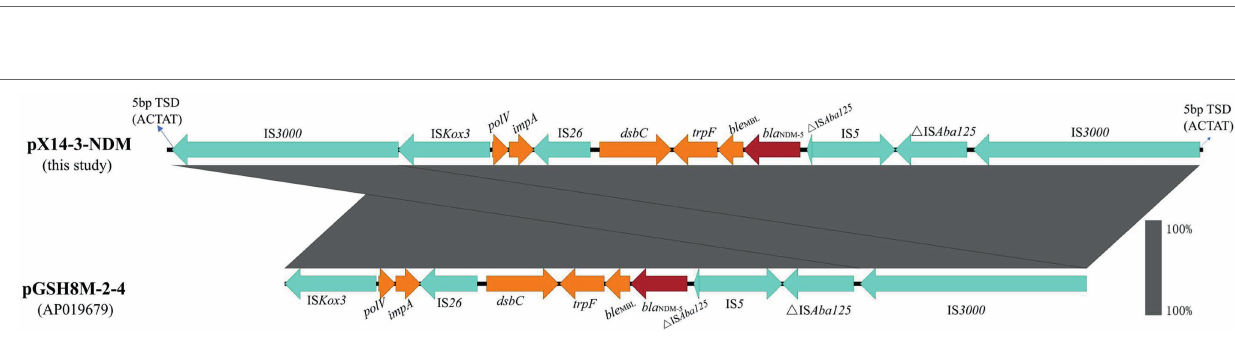
FIGURE 1 | Circular plasmid map of pX14-3-NDM. Pink, blue, red, turquoise, and cyan arrows represent genes responsible for antimicrobial resistance, mobile element, plasmid replicon, mercuric resistance, and other functions, respectively.